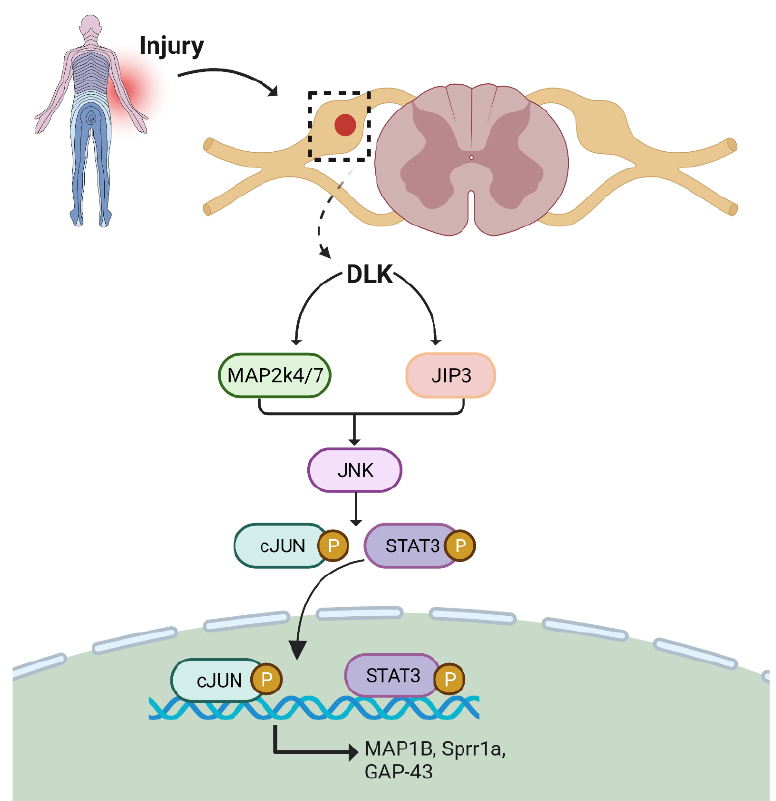
Figure 2. DLK/JNK/MAPK pathway . DLK acts on JIP3 and MAP2k4/7 to activate JNK-mediated STAT3 and cJUN to enhance axon regeneration. DLK: dual leucine zipper kinase; JIP3: JNK-interacting protein 3; MAP2k4/7: mitogen-activated protein kinase; JNK: c-Jun N terminal kinase; STAT3: signal transducer and activator of transcription 3; Map1b : microtubule-associated proteins; Sprr1a : small proline-rich protein 1A; Gap-43 : growth-associated proteins.